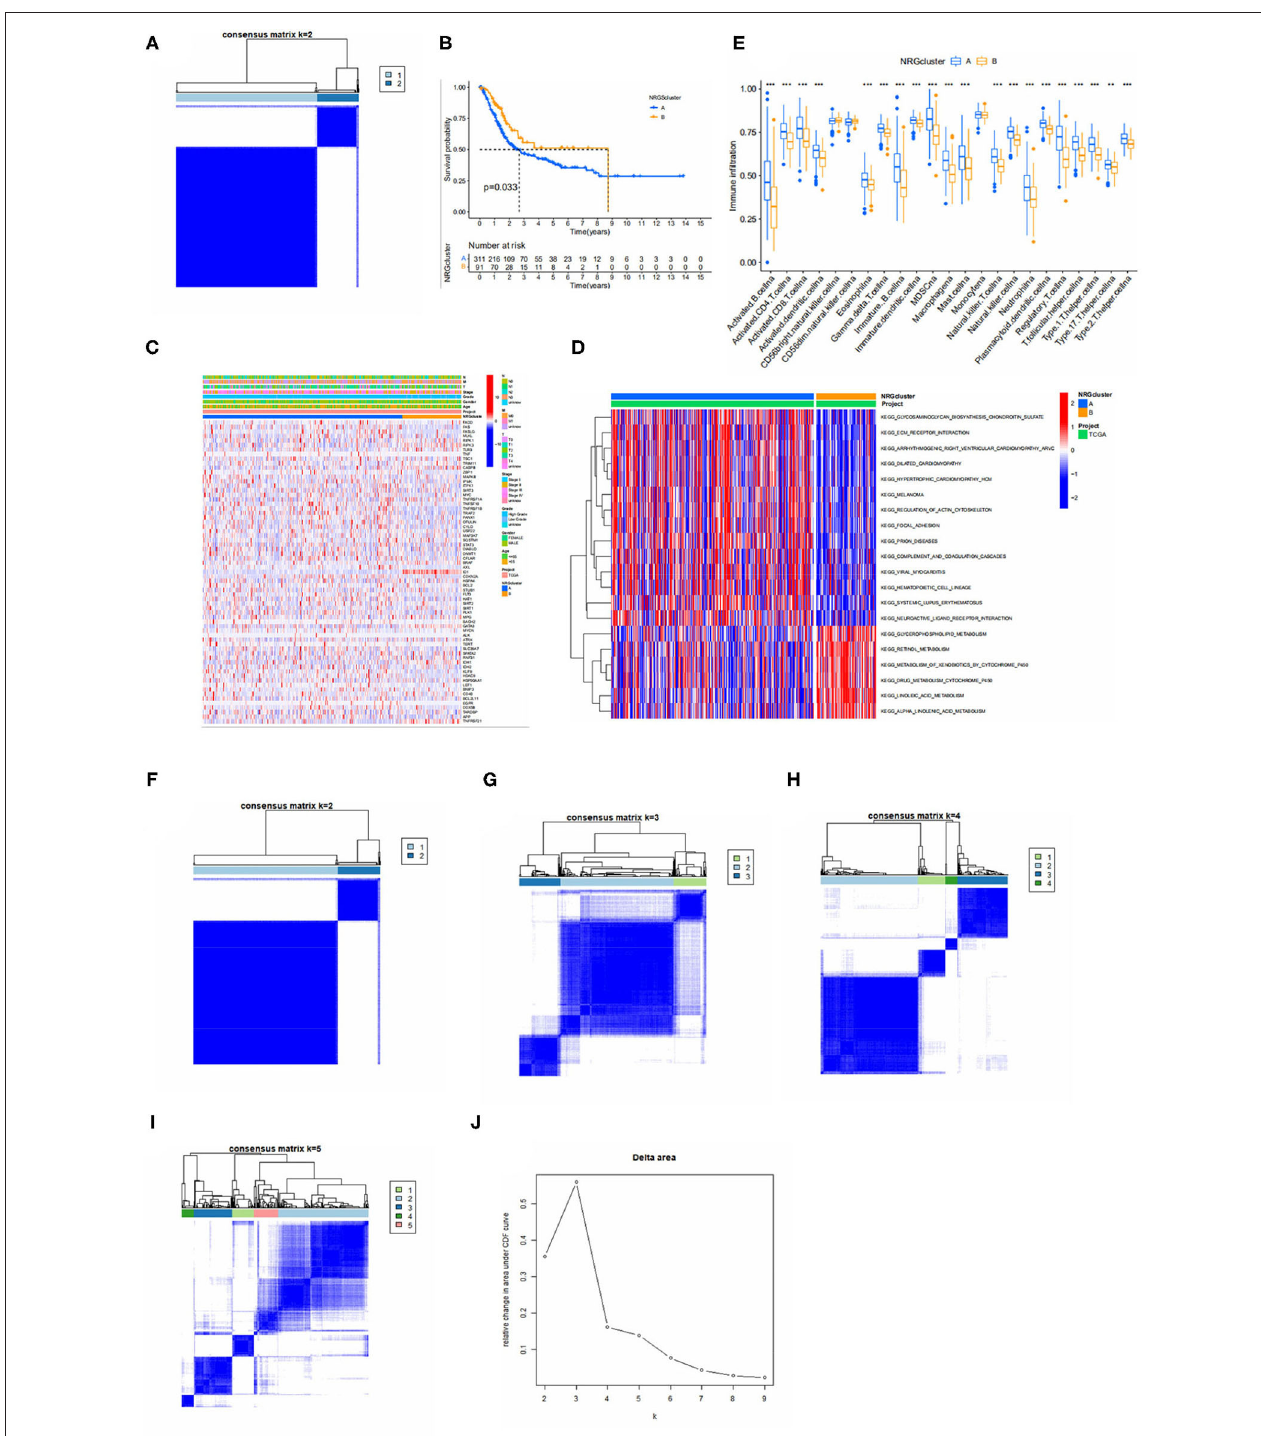
FIGURE 2 | (A) Consensus matrix heatmap defining two clusters ( k = 2) and their correlation area. (B) Kaplan-Meier analysis curves of NRGS subtypes. (C) Differences in clinicopathologic features and expression levels of NRGs between the two distinct subtypes. (D) GSVA of biological pathways between two distinct subtypes, in which red and blue represent activated and blue inhibited pathways, respectively. (E) Relative content of 23 immune cells in different Necroptosis subtypes. (F–I) Defined as two, three, four and five subtypes ( k = 2, 3, 4, and 5) and their areas. (J) Cumulative distribution function curve. The figure shows a consistent cumulative distribution function plot for each type of clustering (different k ) to determine the choice of k when the CDF is maximized so that consistency and clustering confidence are maximized.